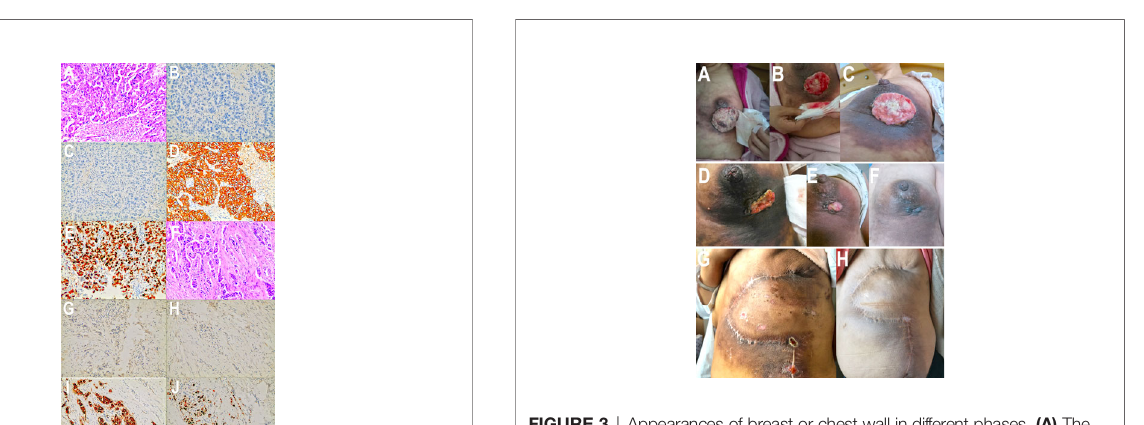
FIGURE 3 | Appearances of breast or chest wall in different phases. (A) The appearance of breast before ECH regimen in March 2018. (B) The appearance of breast after two cycles of ECH regimen in April 2018. (C) The appearance of breast after four cycles of ECH regimen in May 2018. (D) The appearance of breast before pyrotinib plus capecitabin regimen in August 2018. (E) The appearance of breast after two cycles of pyrotinib plus capecitabin regimen in October 2018. (F) The appearance of breast after six cycles of pyrotinib plus capecitabin regimen in October 2018. (G) The appearance of left chest wall 5 months after surgery in June 2019. (H) The appearance of left chest wall 26 months after surgery in March 2021.